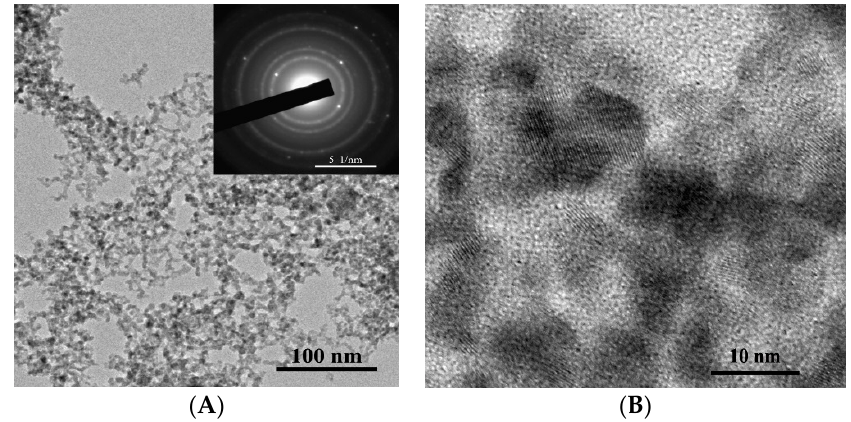
Figure 3. TEM images of the as-synthesized nanoparticles at different magnifications ( A , B ); electron diffraction pattern (inset of figure ( A )).